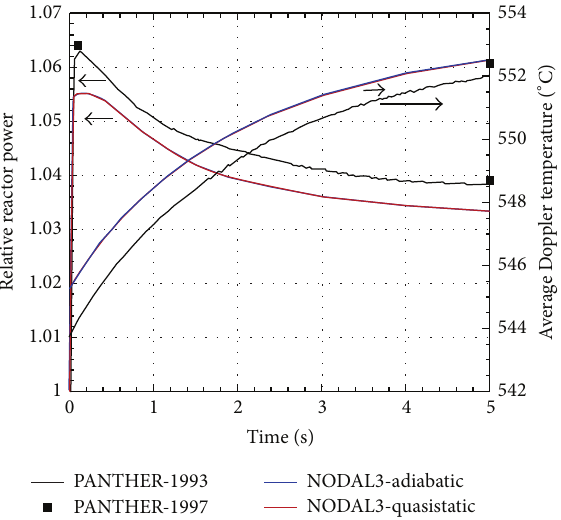
Figure 7: Comparison between NODAL3 and references results for case A2.